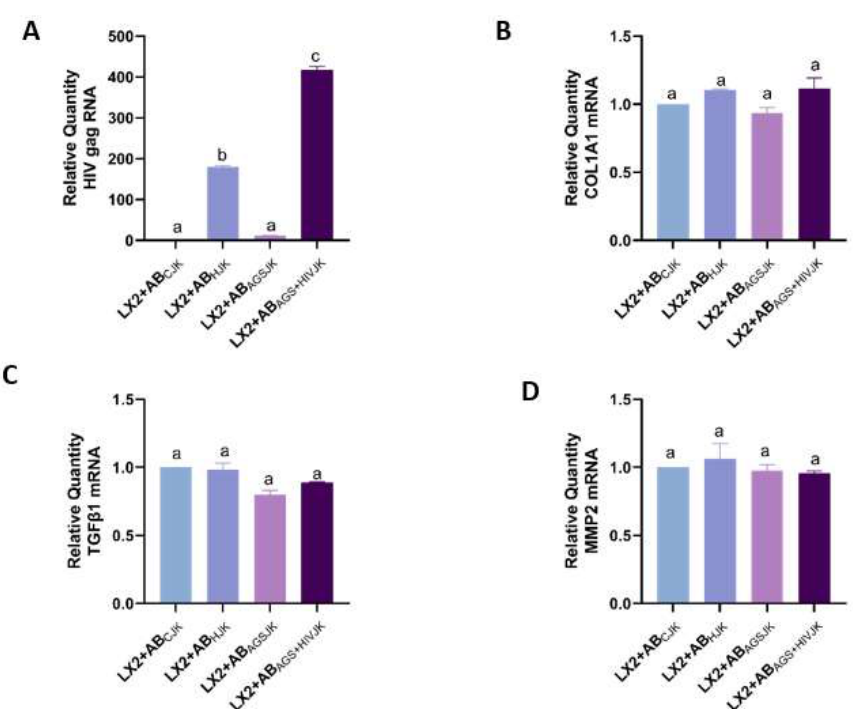
Figure A2. Cells do not express TIM family protein receptors. Flow cytometric measurement of ( A ) TIM1, ( B ) TIM3.